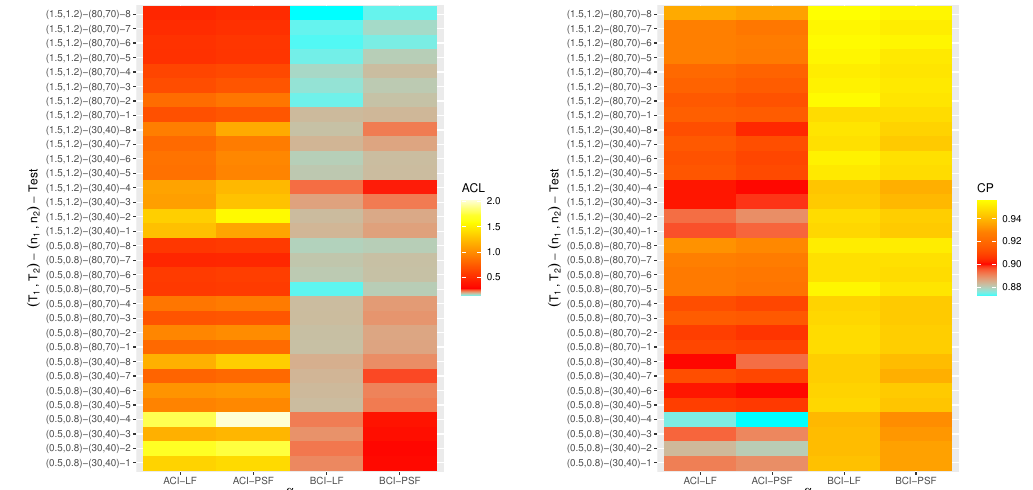
Figure 4. Heatmap for the estimation results of α using Set 2.